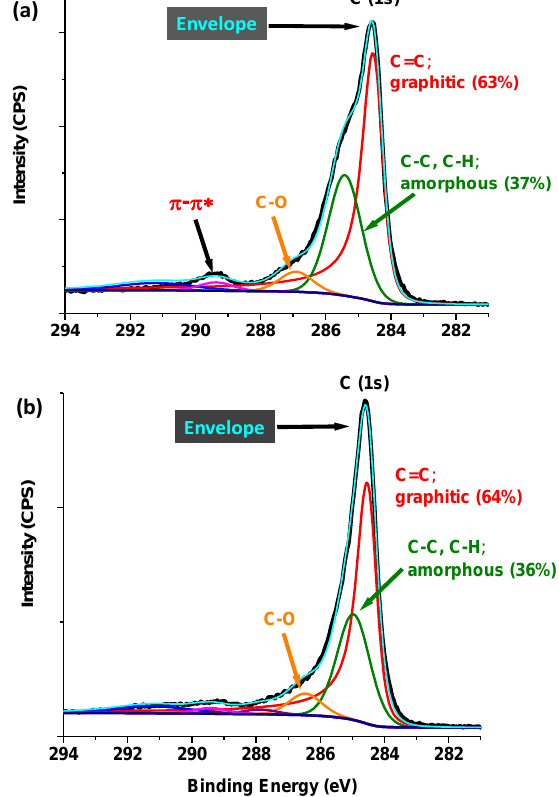
Figure 17. The XPS plots quantifying the C-support in the fresh Co-Fe/C catalyst samples collected from ( a ) the main plasma reactor and ( b ) the secondary plasma reactor.